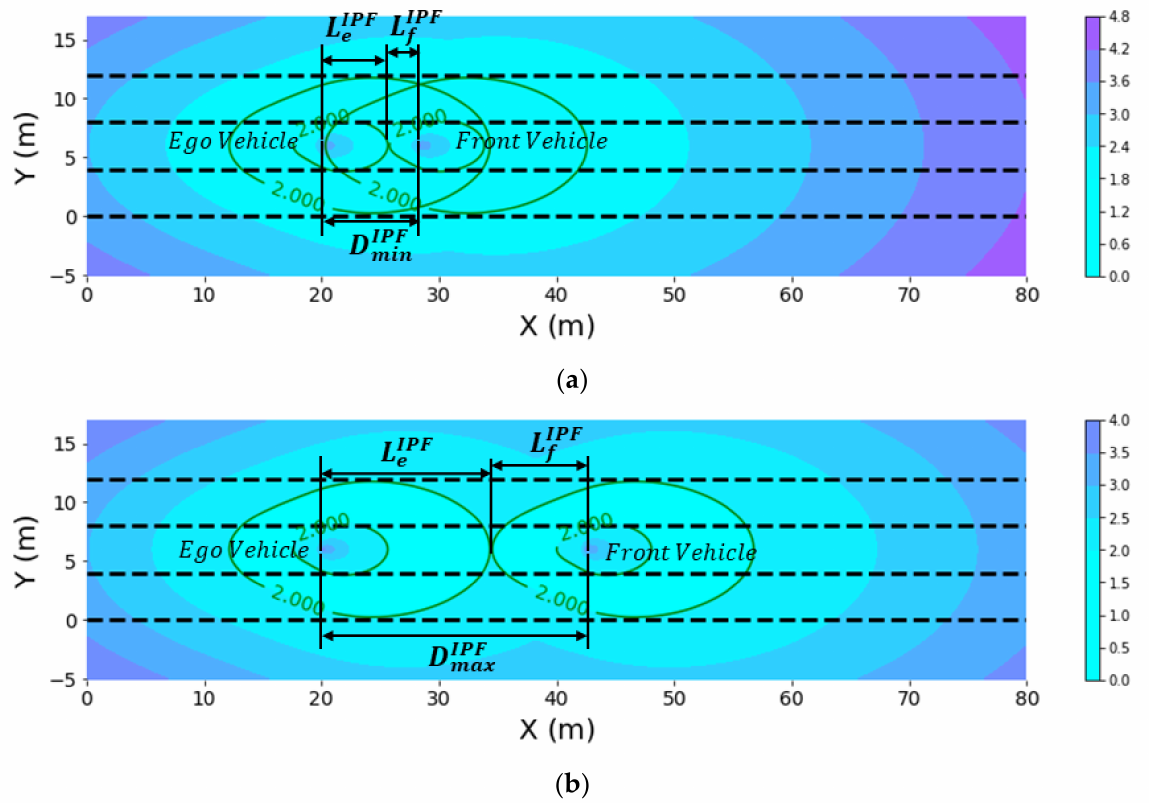
Figure 5. The critical situations of rear-end collisions: ( a ) the inner circles of the fields are tangent to each other and ( b ) the outer circles of the fields are tangent to each